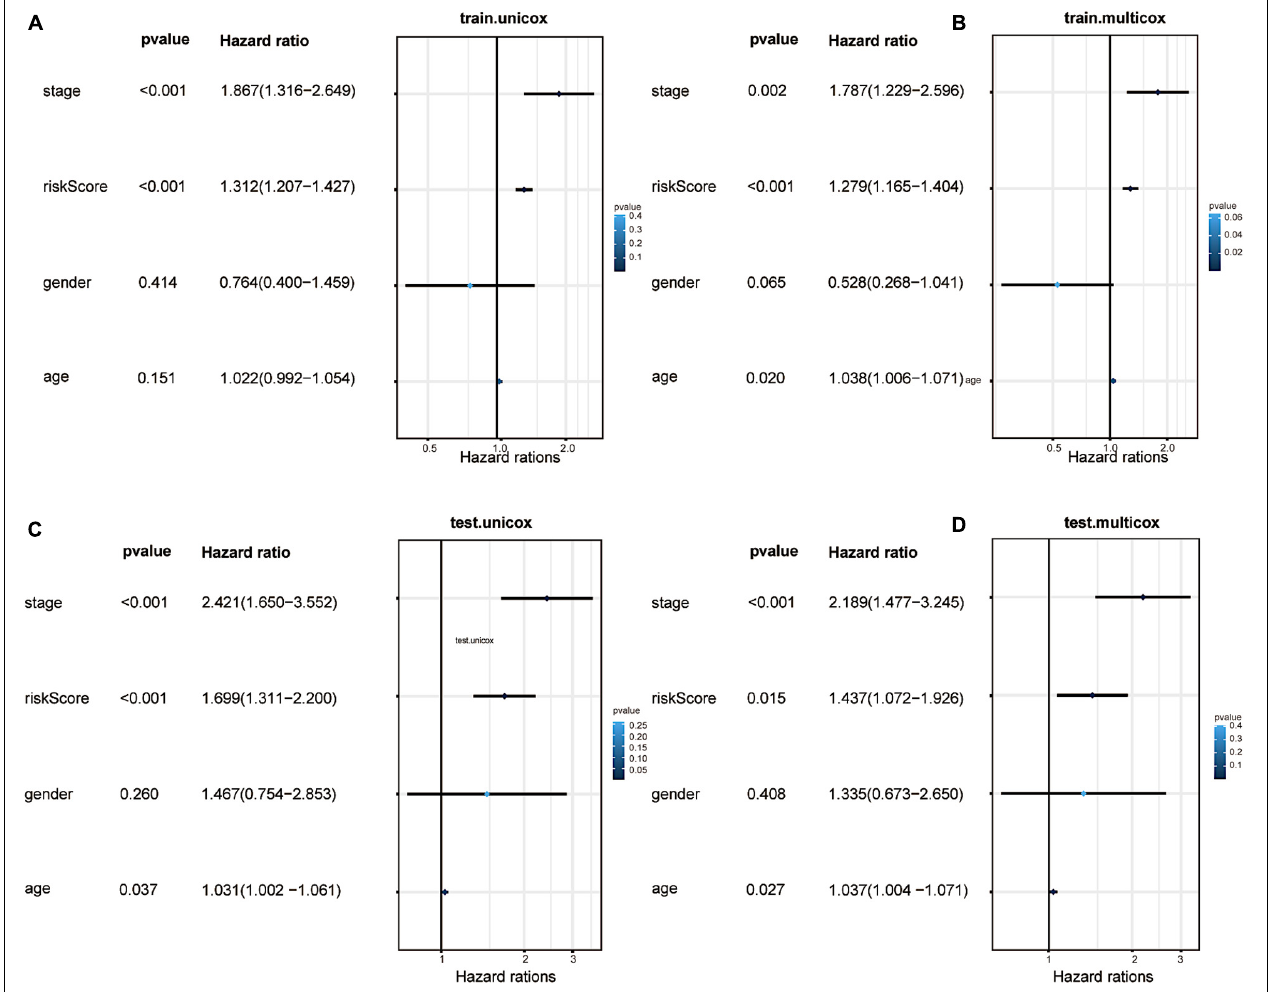
FIGURE 7 | Factor analysis and confirmation of independence. (A) Univariate analyses illustrated that the risk score (based on the 16 m6A-related prognostic lncRNAs) was an independent prognostic predictor in the training group. (B) Multivariate analyses illustrated that the risk score was an independent prognostic predictor in the training group. (C) Univariate analyses illustrated that the risk score was an independent prognostic predictor in the testing group. (D) Multivariate analyses illustrated that the risk score was an independent prognostic predictor in the testing group.